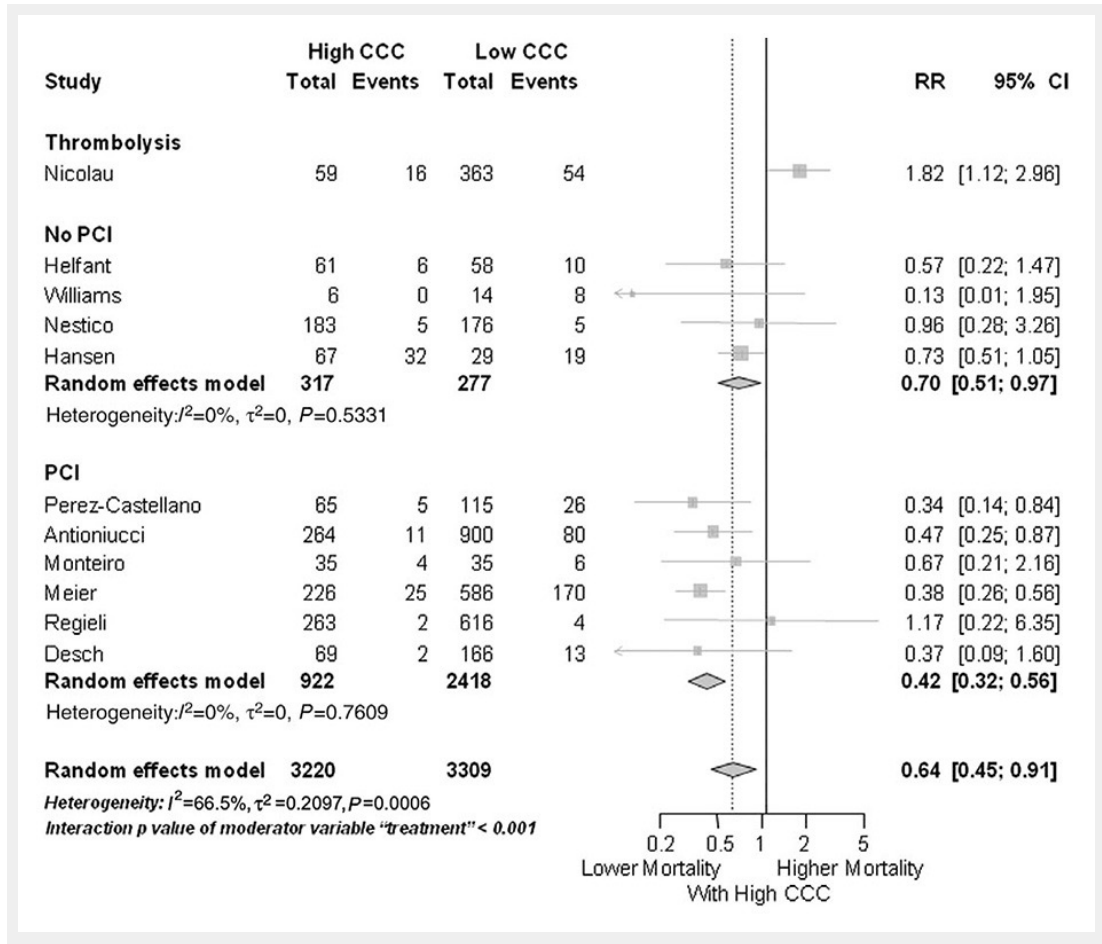
Figure 7 Forest plot of risk ratios for mortality risk, stratified by type of intervention (PCI, no PCI, and thrombolysis). CAD, coronary artery disease; CCC, coronary collateral circulation; CI, confidence interval; MI, myocardial infarction. Horizontal bars indicate 95% confidence intervals. (Data from Meier P, et al. Beneficial effect of recruitable collaterals: a 10-year follow-up study in patients with stable coronary artery disease undergoing quantitative collateral measurements. Circulation. 2007;116:975–83 [40], by permission of Oxford University